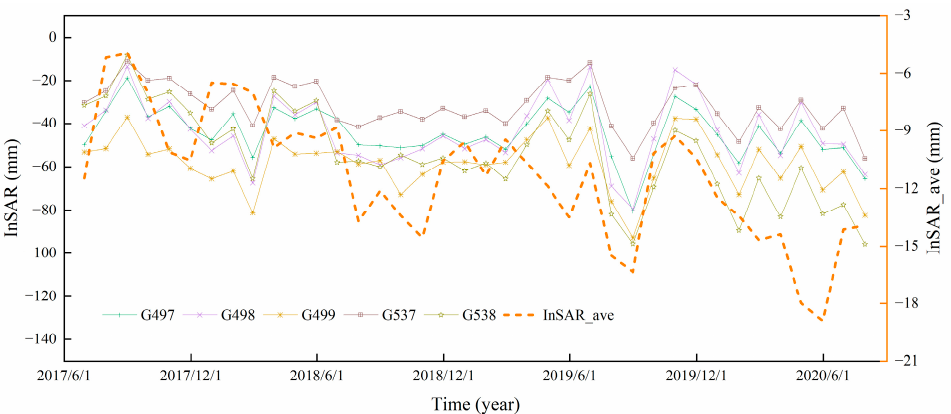
Figure 13. Comparison of subsidence sequence between individual grids nearby site BJSH and average values in the northern Beijing Plain.